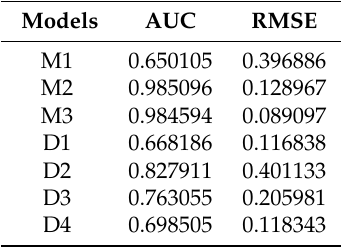
Table 11. Performance for the seven models using the top 10 features from model D4 on the test